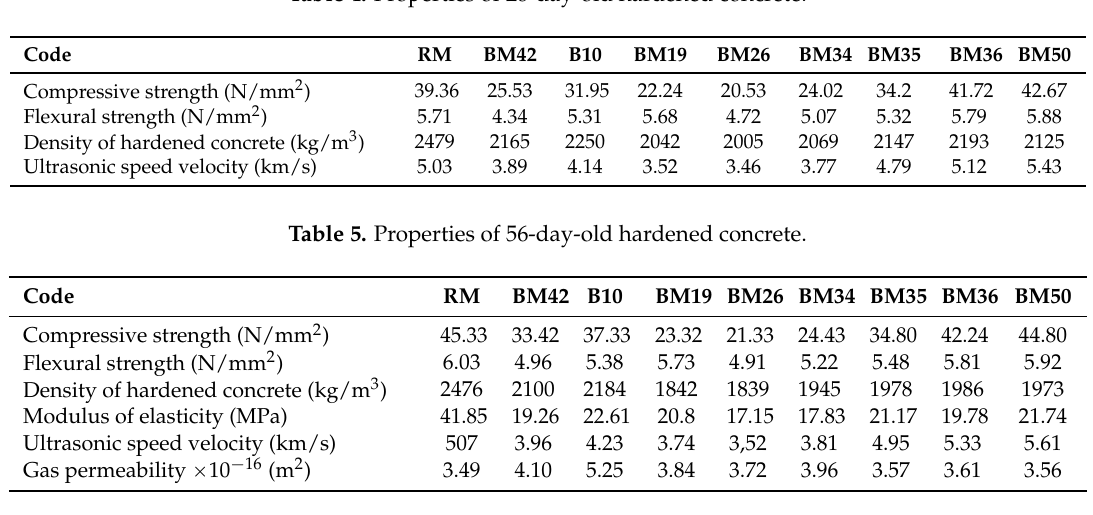
Table 4. Properties of 28-day-old hardened concrete.